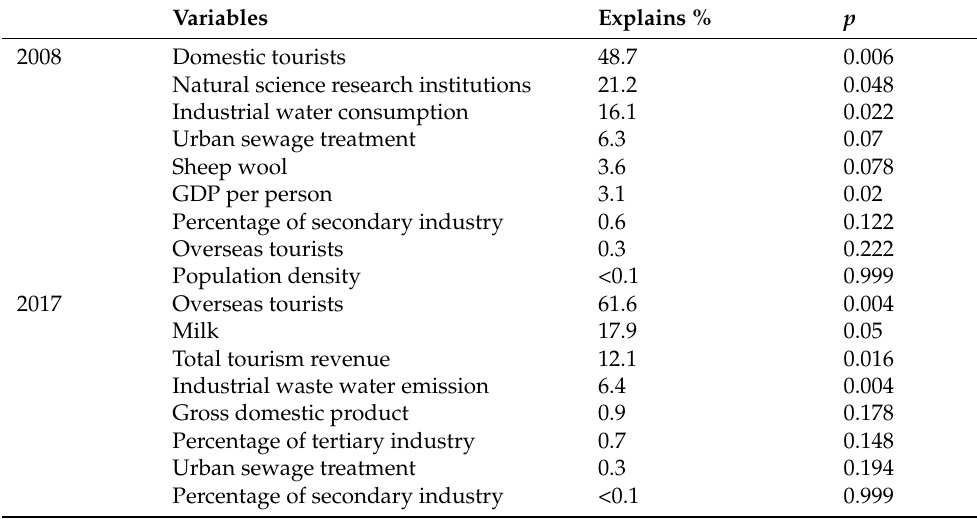
Table 4. Explanatory ability of significant variables in 2008 and